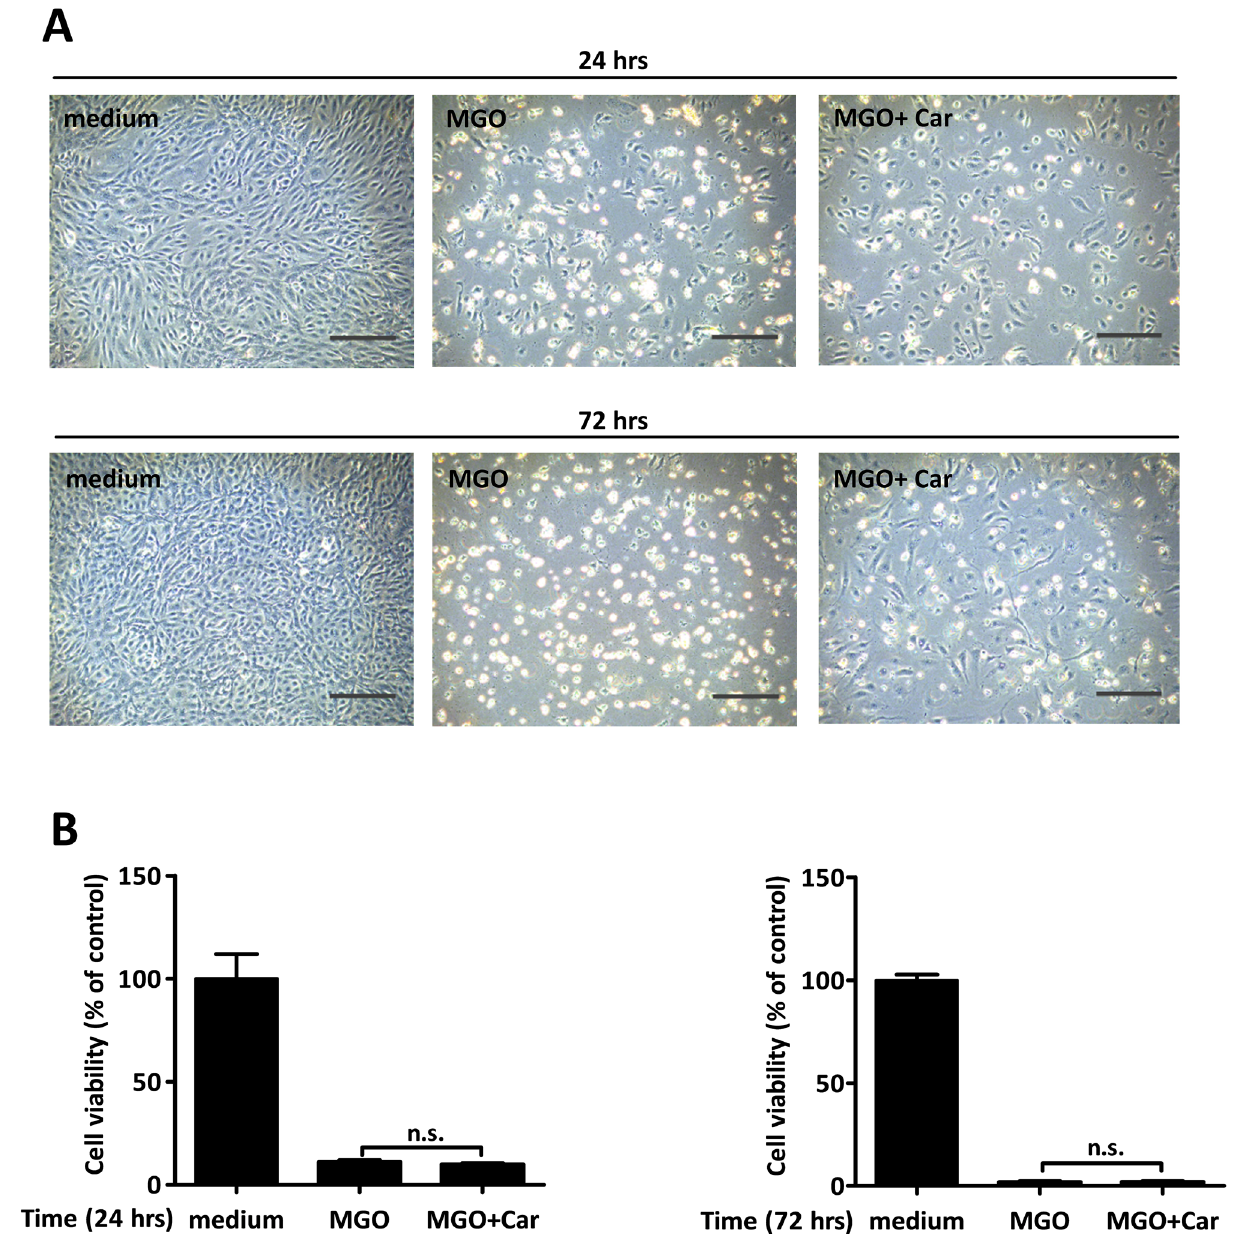
Figure 6. Carnosine does not alleviate MGO-mediated cell toxicity. HUVECs were challenged with 800 µM of MGO for a total period of 72 h in the absence or presence of 20 mM carnosine (Car). ( A ) Morphological changes were monitored by phase contrast microscopy at 24 h (upper panel) and 72 h (lower panel). Original magnification: 10x, scale bar represents 250 µm. ( B ) MTT assay was employed to assess cell viability at 24 h (figure to the left) and 72 h (figure to the right). The results are expressed as mean % of viable cells ± SD of 5 independent